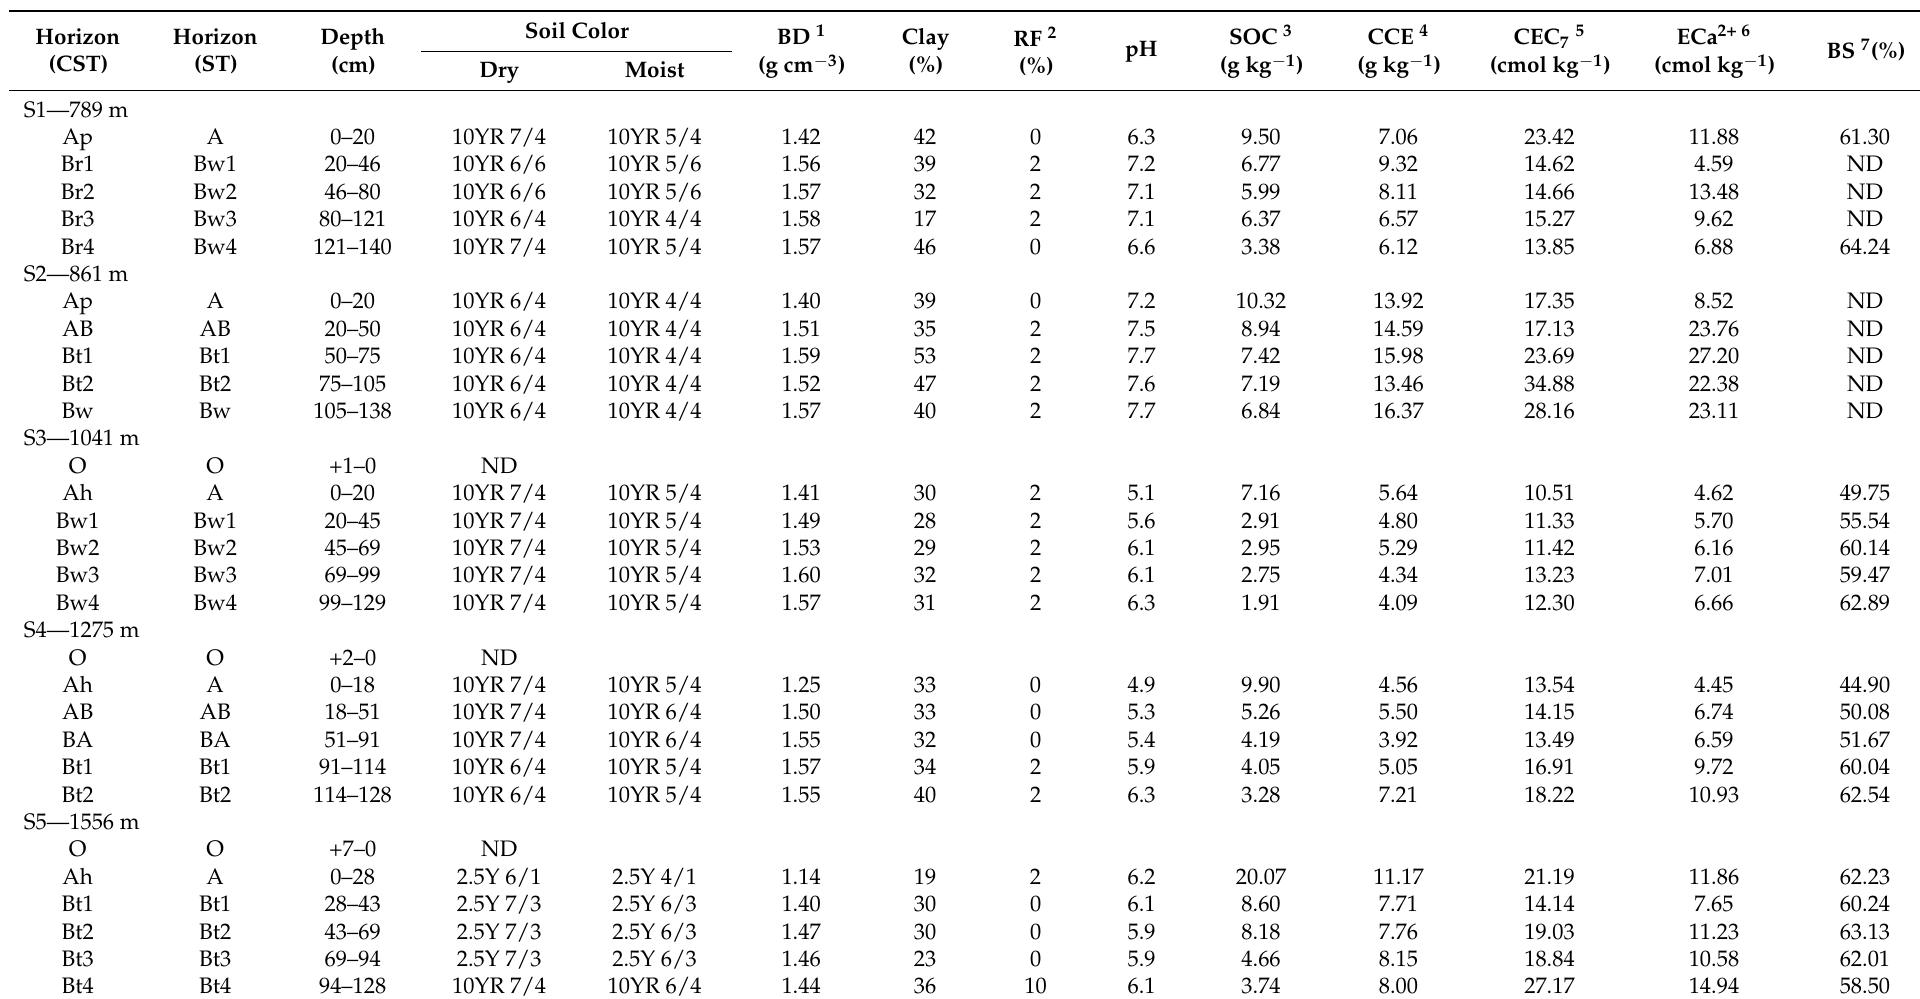
Table 2. Morphological, physical, and chemical properties for soils derived from carbonate rocks along a climosequence in a subtropical mountain, China.